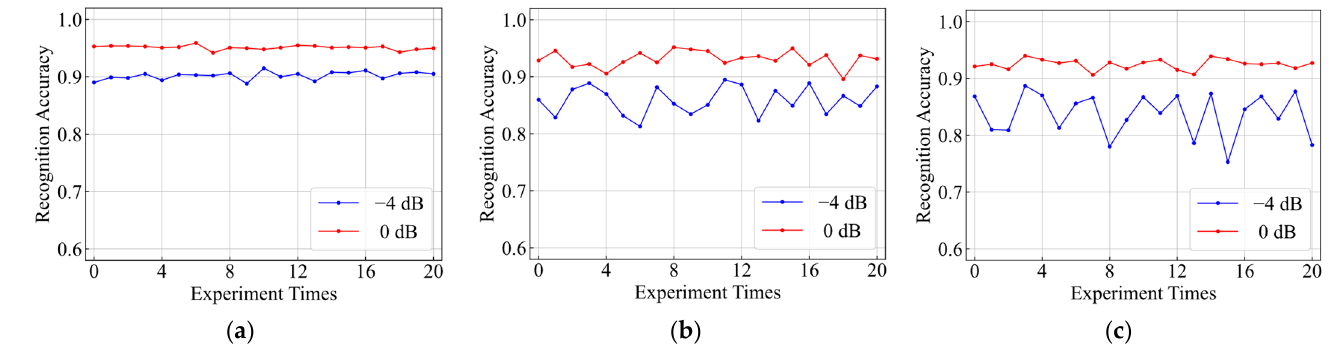
Figure 12. Robustness comparison of different models: ( a ) ours model; ( b ) CPN; ( c ) OpenMax.